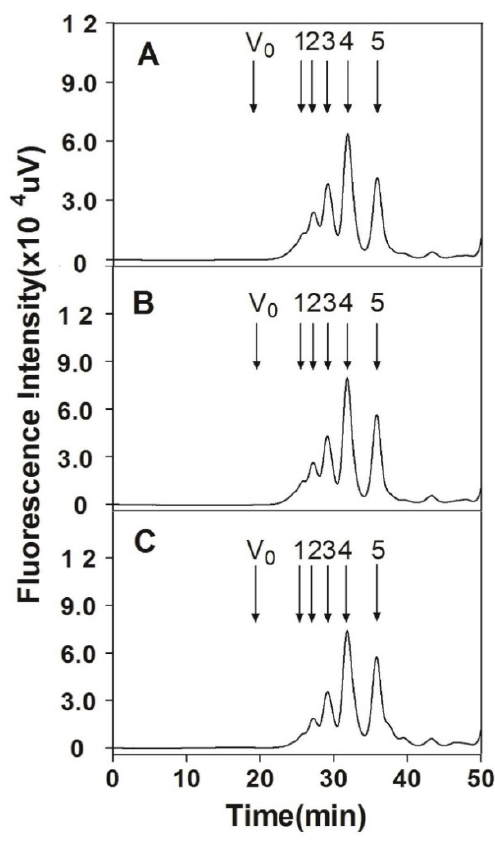
Figure 6. Preparation of size-defined oligosaccharides. SHCS ( A ), SBCS ( B ), or SFCS ( C ) was digested with hyaluronidase, and after 2-AB labeling, the digest was fractionated on a Superdex TM Peptide 10/300GL column as described under “Section 2”. Vo, void volume. The elution positions of 2AB-labeled authentic unsaturated CS-derived standard oligosaccharides determined are indicated by arrows as follows: 1, CS-dodecasaccharides; 2, CS-decasaccharides; 3, CS-octasaccharides; 4, CS-hexasaccharides; 5, CS-tetrasaccharides.